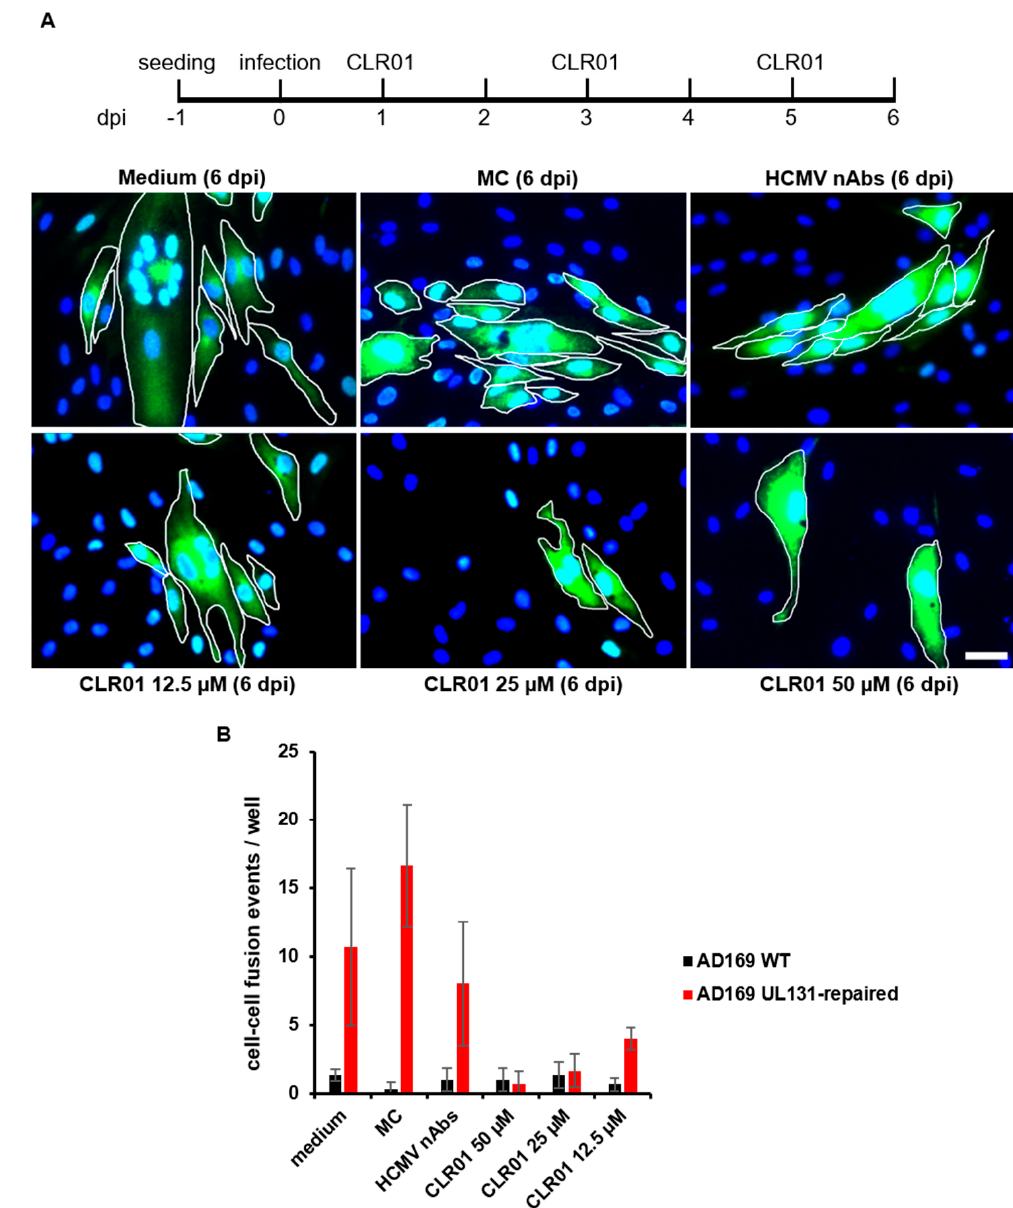
Figure 7. CLR01 inhibits cell–cell fusion of cells infected with AD169 UL131-repaired HCMV strain. ( A ) Human fibroblasts were infected with AD169 UL131-repaired HCMV strain (corresponding to an infection of about 0.1–1%). Different conditions (medium, methylcellulose (MC) overlay, HCMV-neutralizing antibodies (nAbs; 5 mg/mL Gamunex), and indicated concentrations of CLR01) were applied 1 dpi and renewed every 48 h. Focal growth and the formation of cell–cell fusion were determined by indirect immunofluorescence of HCMV tegument protein pp65 at 6 dpi. Blue, DAPI-positive cells; green, HCMV-positive cells; white, cell borders. Scale bar is 50 µ m. ( B ) Focus expansion assays were performed with AD169 and AD169 UL131-repaired strain as described in A. Cell–cell fusion events were quantified from triplicate infection. A cell–cell fusion event was defined as at least two cell nuclei within one cell, whereby the different numbers of cell nuclei within cell–cell fusion events was not